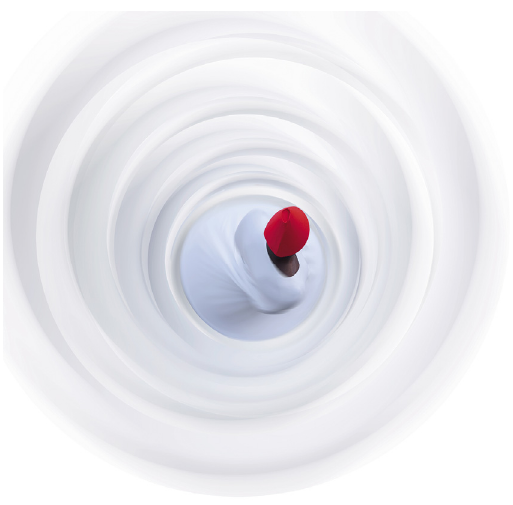
Figure 5. Maïmouna Guerresi, Illumination 1, 2010. Lambda print on aluminum. 120 × 120 cm. © Maïmouna Guerresi, courtesy Mariane Ibrahim Gallery.